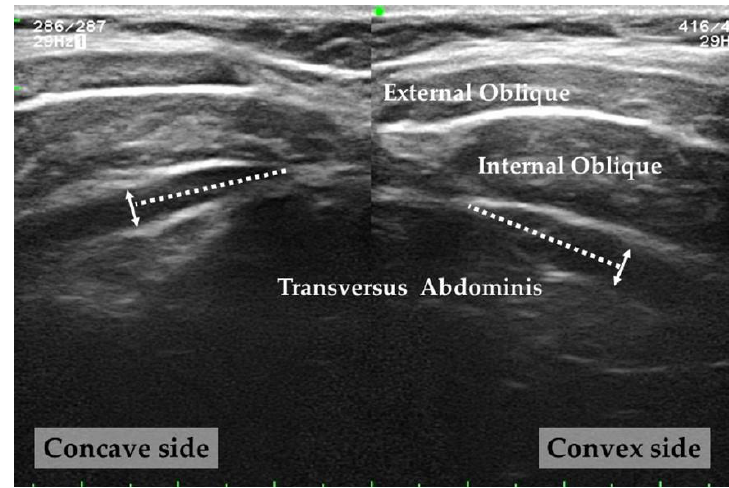
Figure 2. Ultrasound imaging measurement.